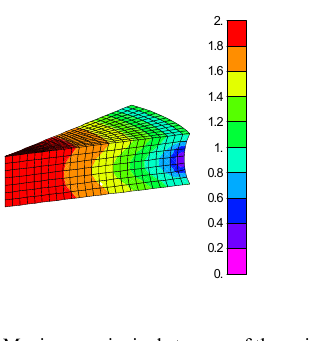
Figure 7: Comparison of maximum principal stresses for different point supports at beginning